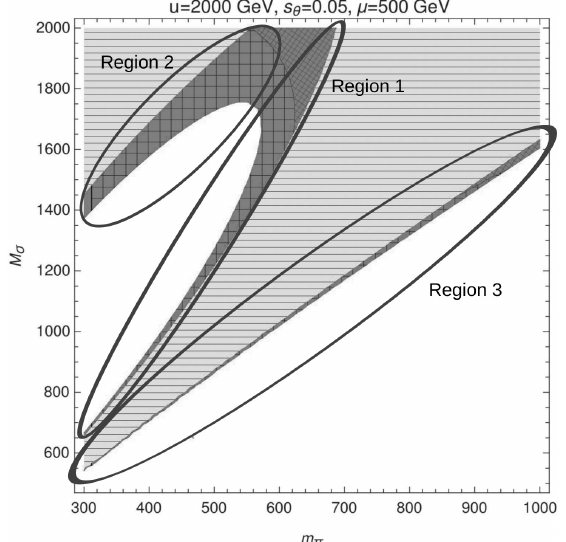
Figure 1. Numerical solution of kinetic equations system in a phase diagram in terms of M ˜ σ and m ˜ π , other parameters are also indicated.